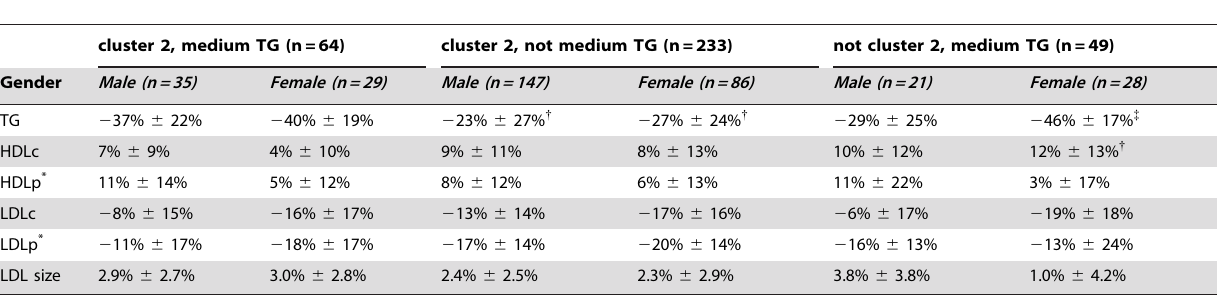
Table 5. Percent changes after fenofibrate intervention in medium TG subgroup versus lipoprotein cluster 2.